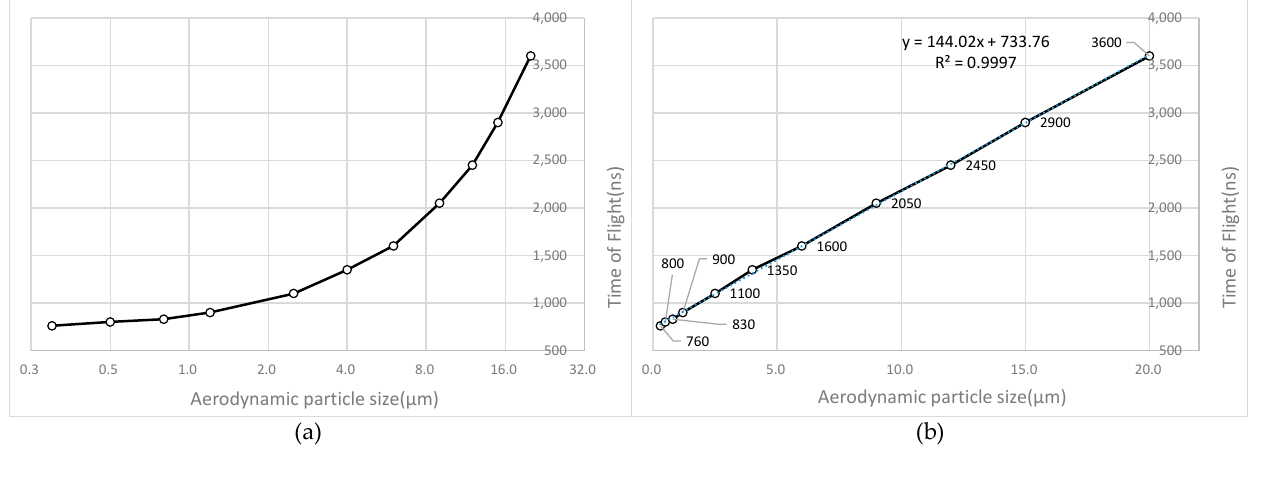
Figure 8. TOF of aerodynamic particle size of PM0.3-PM20. ( a ) A logarithmic base of 2 is used for the abscissa to facilitate viewing the values. ( b ) In order to view linearity comfortably, the abscissa is normal. Time-of-flight data for 11 different standard particle diameters were obtained, and Figure 8 illustrates the results. The time-of-flight of particles 0.3–20 µ m is approximately 700 ns to 4000 ns. In Figure 8b, it is evident that the particle size is linearly proportional to time-of-flight. Figure 9 shows the data collected by ADC when calibrating the instrument with PM1.2.